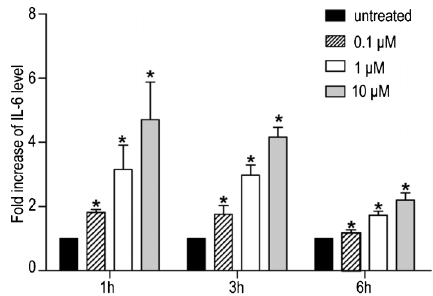
Figure 1. IL-6 production by GES-1 cells incubated with 0, 0.1, 1, 10 m M norepinephrine (NE). Supernatants were harvested at 1, 3, and 6 h. IL-6 levels (pg/mL) were analyzed by ELISA. Data are reported as means±SE. *P , 0.05, compared to control (ANOVA followed by the Newman-Keuls post hoc